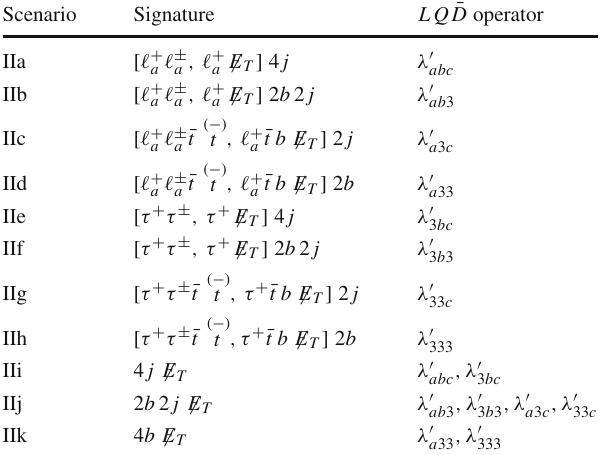
Table 5 Possible final states in the LQ ¯ D case for a pair of neutralino LSPs decaying via the same operator. There will be further accompany- ingparticlesfromthecascadedecayoftheoriginallyproducedparticles, denotes a charged lepton and the indices a , b , c = 1 , 2 denote leptons or quarks from the first or second generation. We have separated out the signatures with no charged lepton. For each listed signature there is